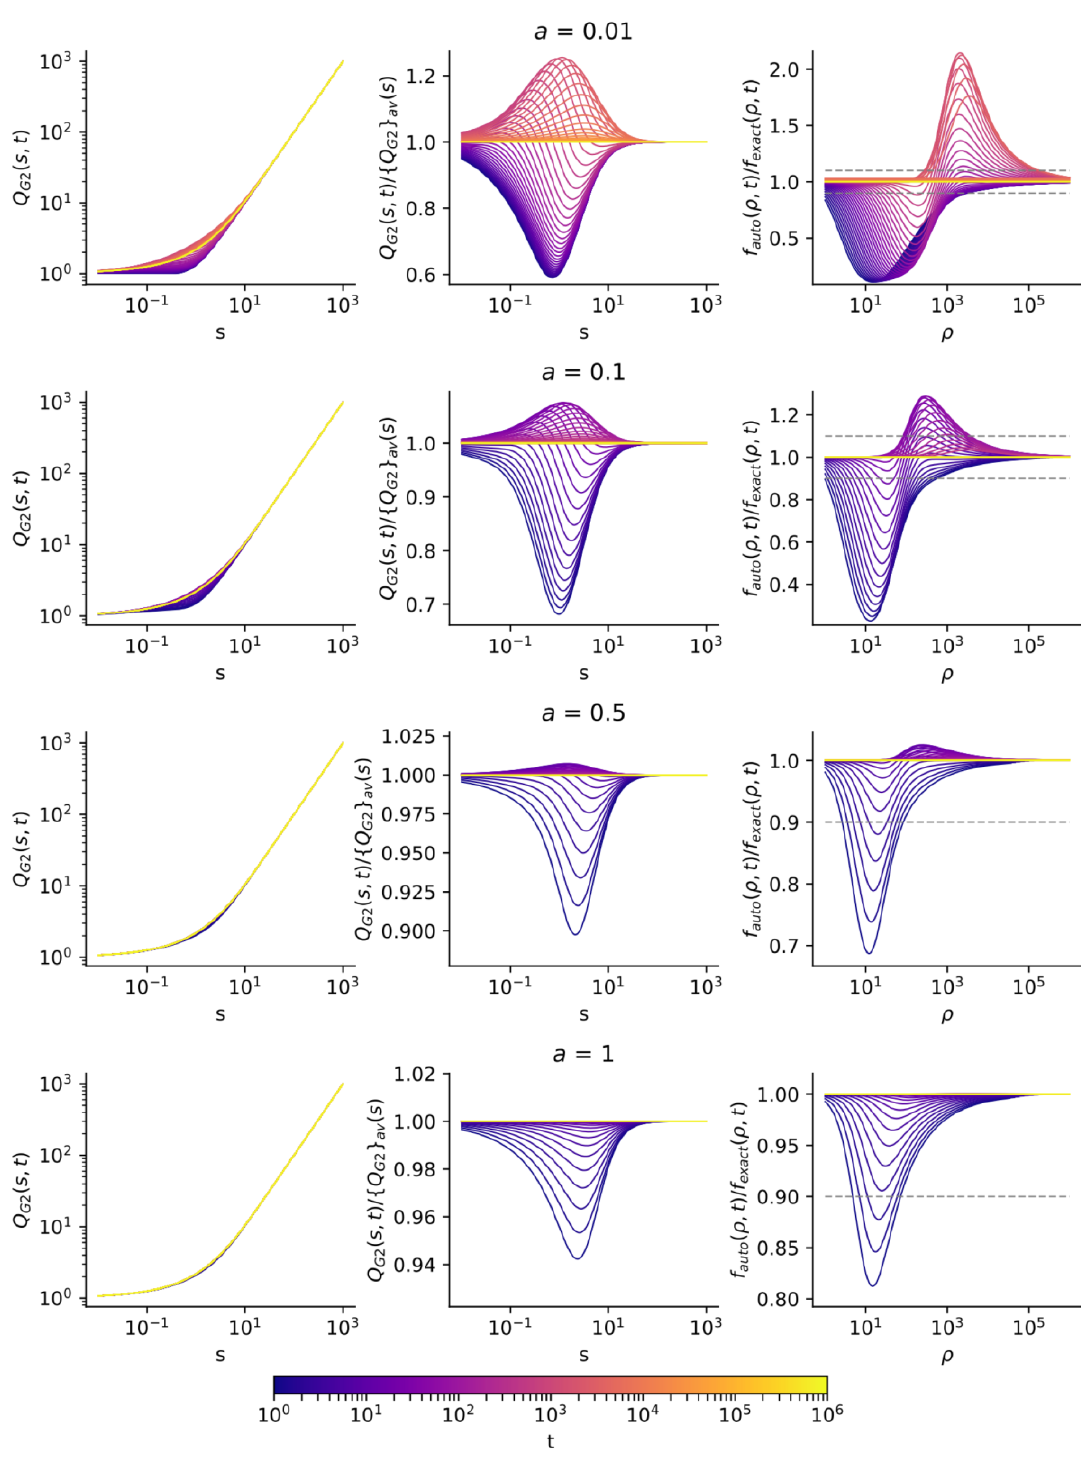
Figure 4. The same as in Figure 2, but for the propagation front ρ = ρ fr taken in the form of Equation (25).